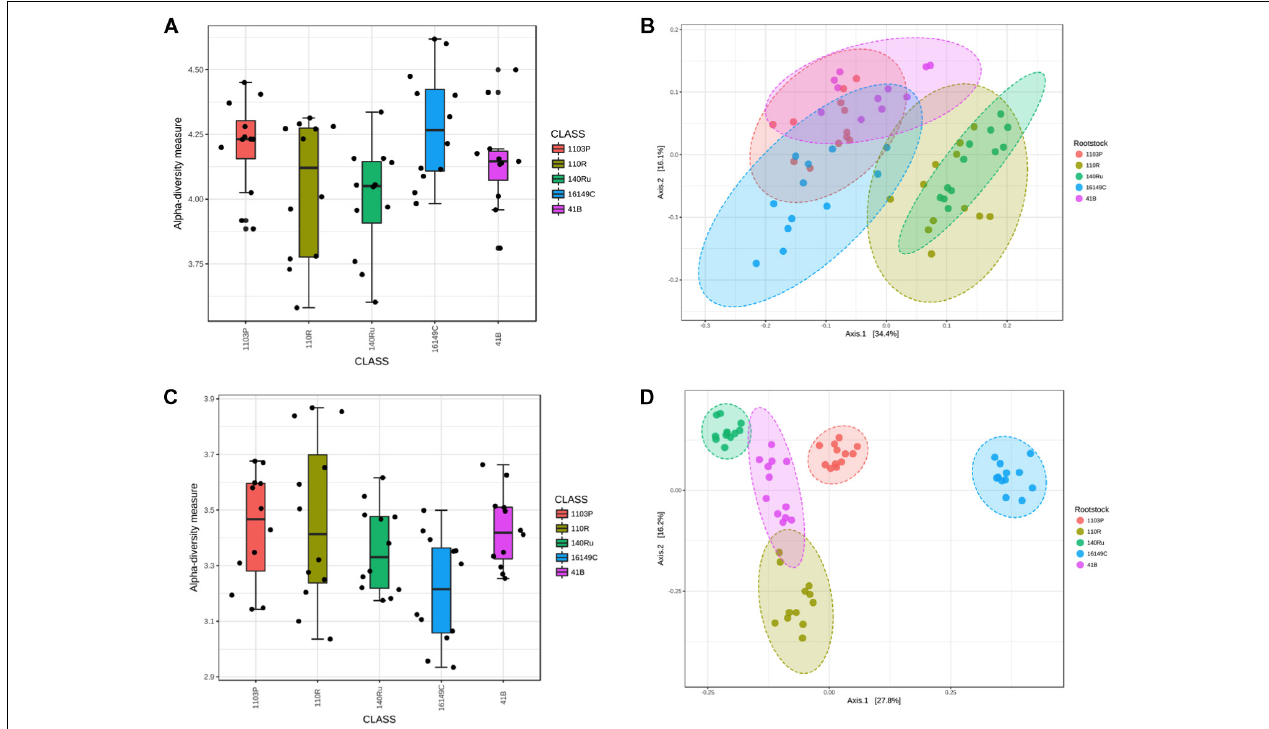
FIGURE 2 | Box plot illustrating the differences in Shannon diversity measures of the bacterial (A) and fungal (C) communities in the grapevine rootstocks in Aldea vineyard. Principal Coordinate Analysis (PCoA) based on Bray Curtis dissimilarity metrics, showing the distance in the bacterial (B) and fungal (D) communities among grapevine